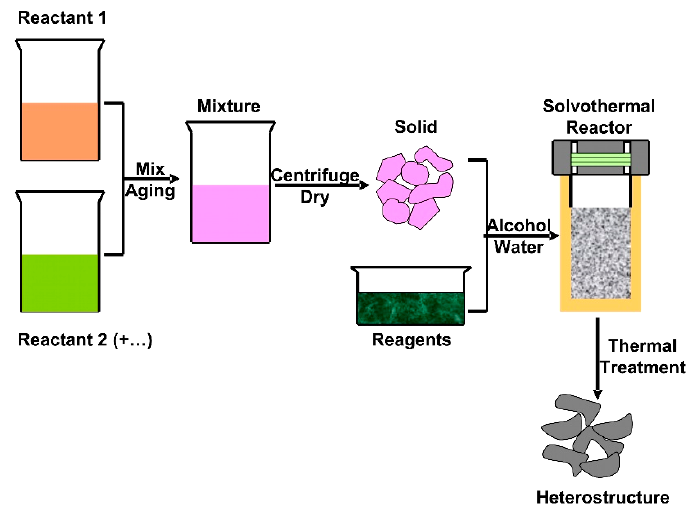
Figure 4. The solvothermal method for heterostructure development.